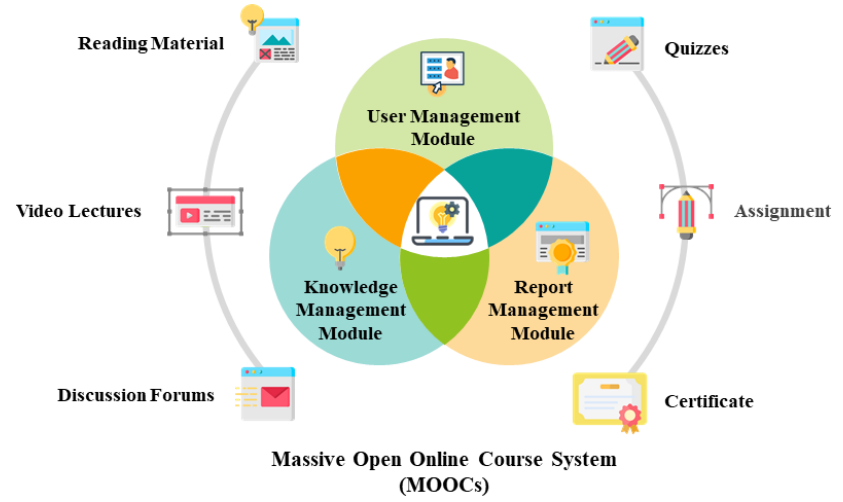
Fig. 1. Elements of Massive Open Online Course System (MOOCs)